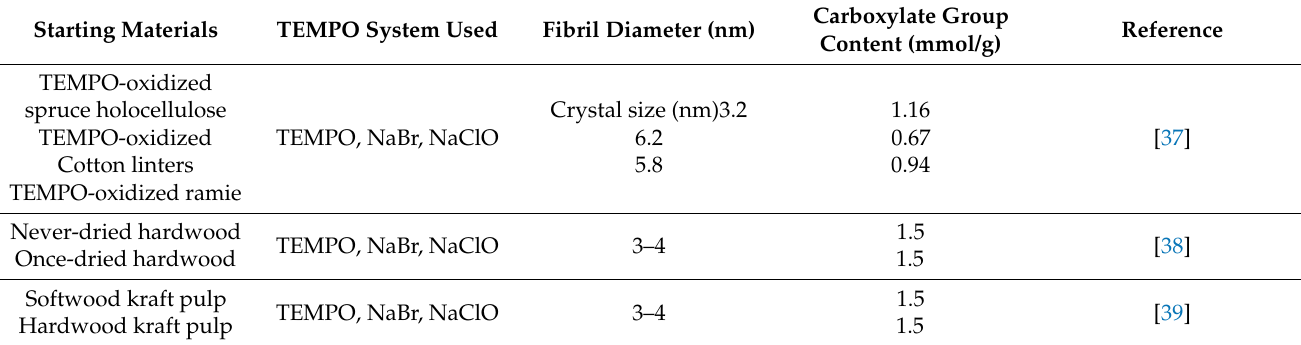
Table 5. Most-cited TEMPO-mediated oxidation pre-treatments addressed in the